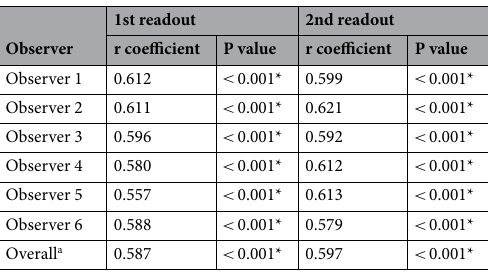
Correlation curve between the colorimetric band density and MMP‑9 concentration. We made standard concentration calibration curve using the 9 different concentrations of MMP-9 solutions (Fig. 2). The curve has steep concentration-gradient progression below the concentration of 100 ng/mL and over 750 ng/ mL and has slow progression between the concentration of 100 ng/mL and 750 ng/mL. There was no revealed plateau up a maximal concentration (i.e. 5000 ng/mL).